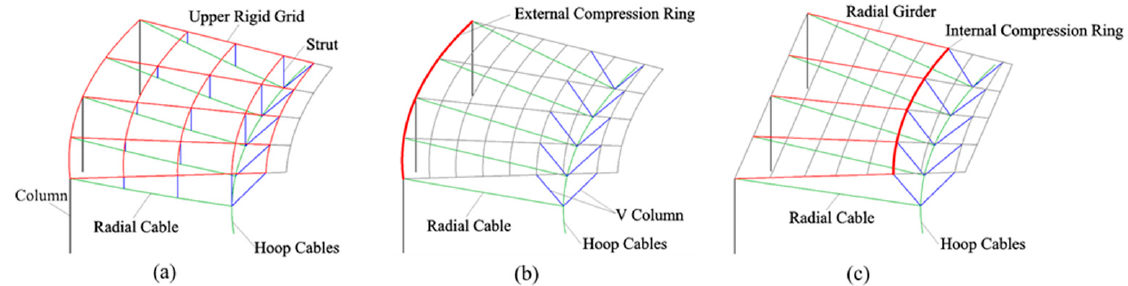
Figure 1. Three categories of CSGS: ( a ) upper grid as a whole compression ring; ( b ) external compression ring; ( c ) internal compression ring.